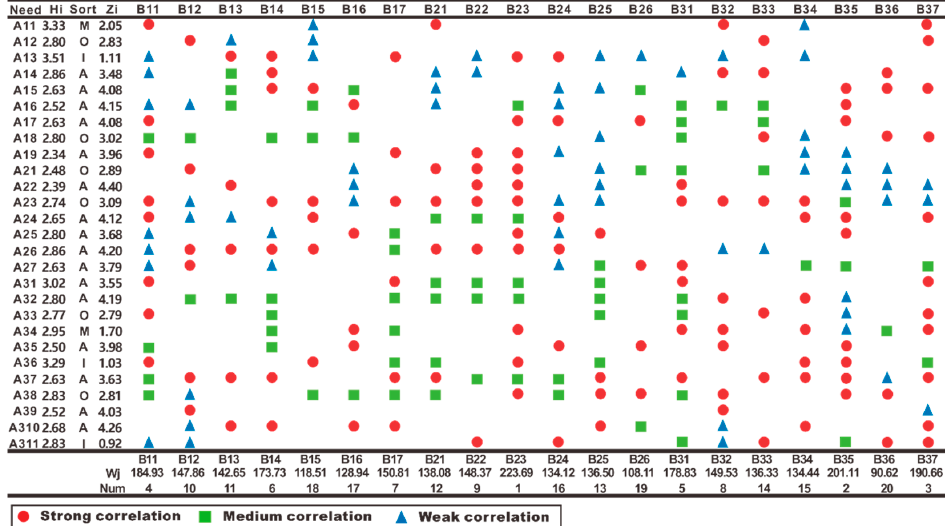
Figure 7. QFD house of quality design importance.